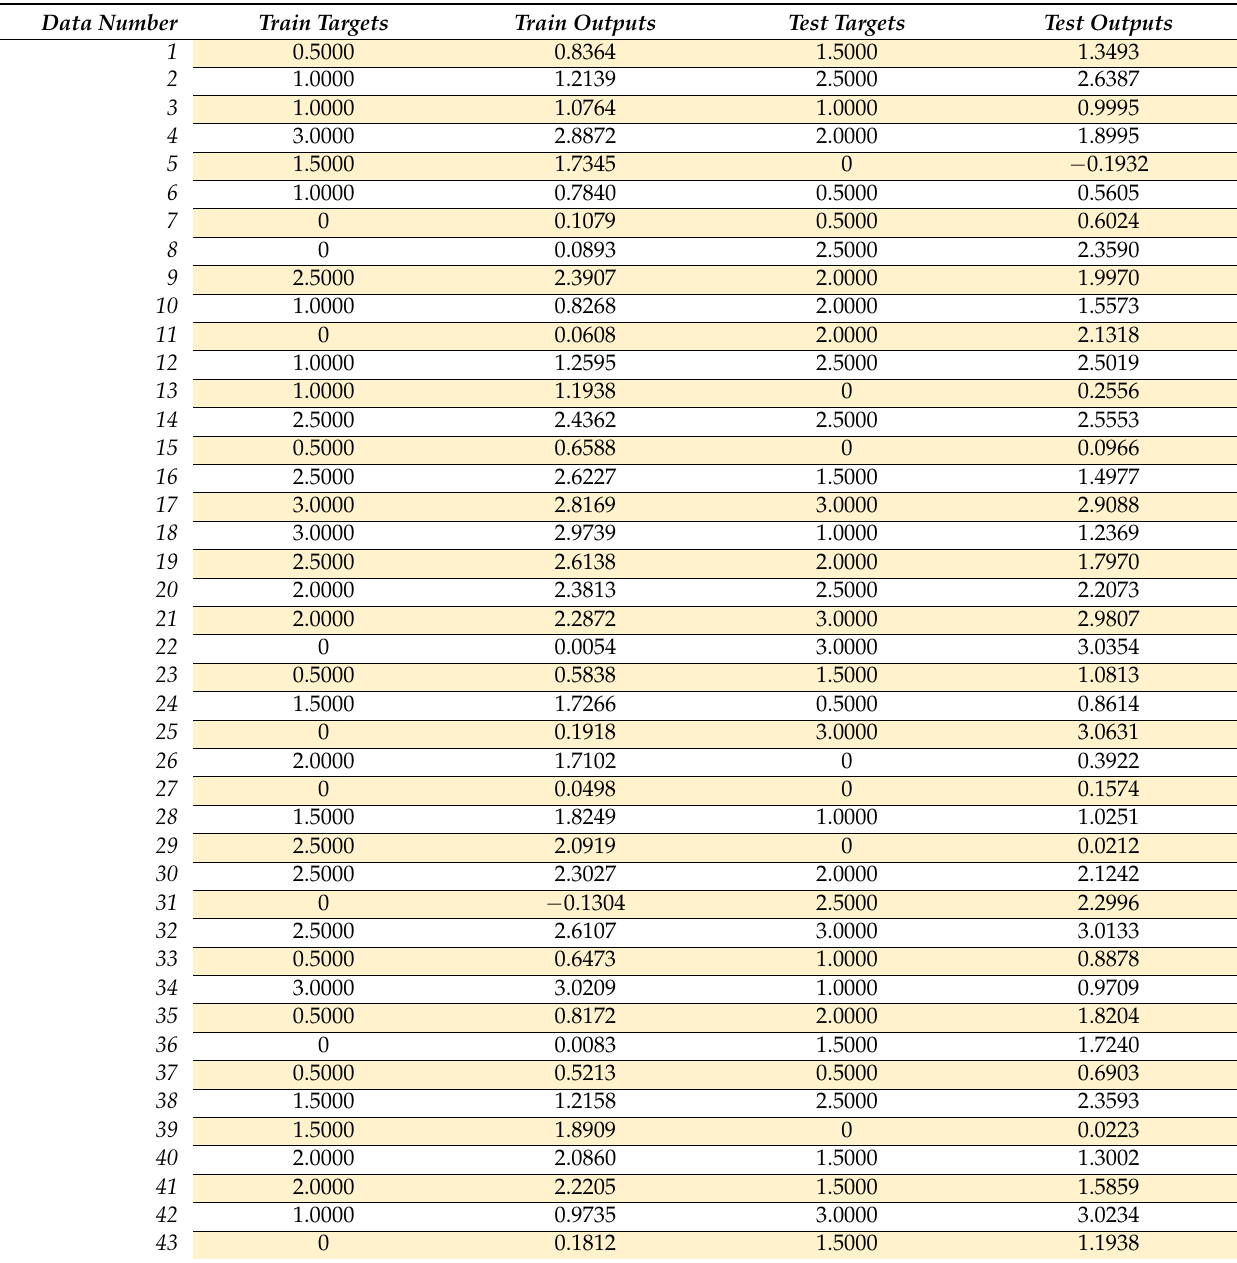
Table 1. Comparison of target values with neural network